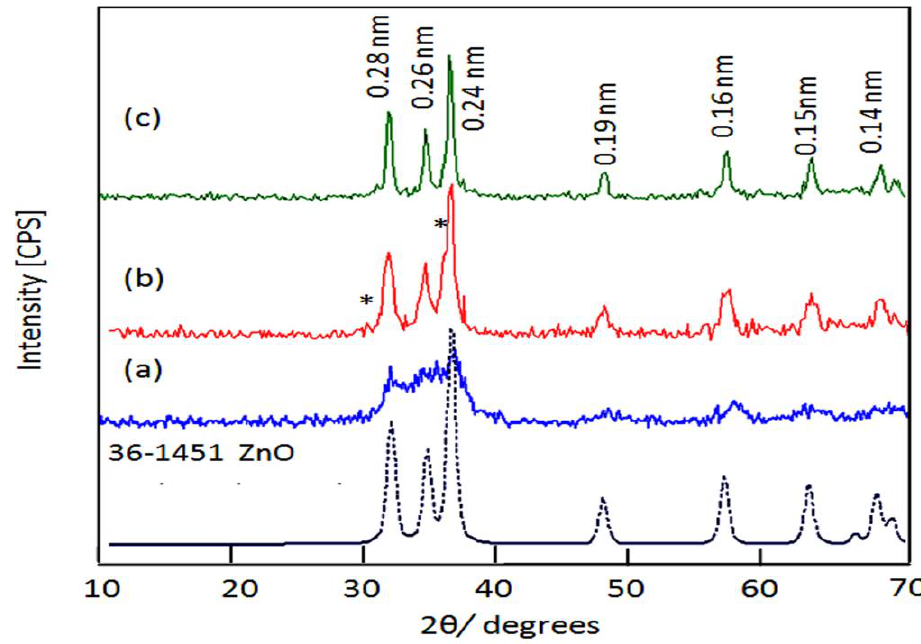
Figure 7. X-ray diffraction patterns of: ( a ) ZA-500, ( b ) NHZ-1-500, and ( c ) NHZ-2-500 (* is due to cobalt iron oxides ).